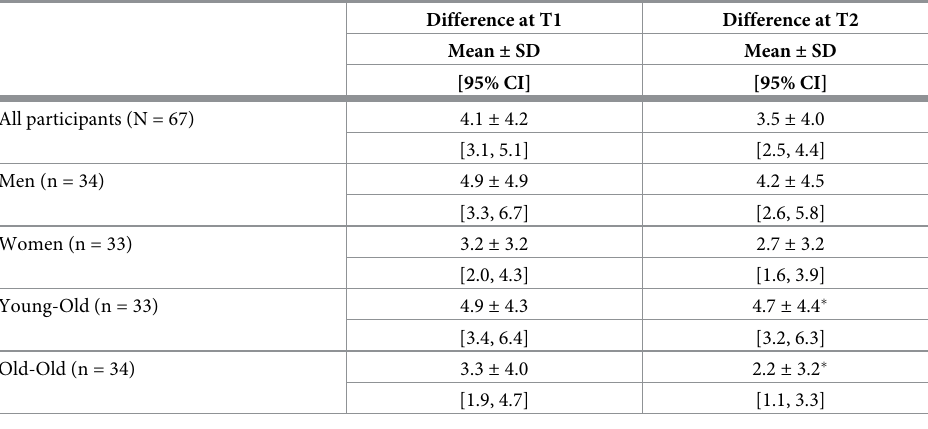
Table 2. Differences in grip strength between the Jamar and Smedley dynamometers at T1 and T2. When strati- fied by gender and age, differences in measurement were similar between Men and Women, and Young-Old (65–75 years) and Old-Old ( > 75 years), except at T2 when the difference between devices was significantly diminished for Old-Old compared to